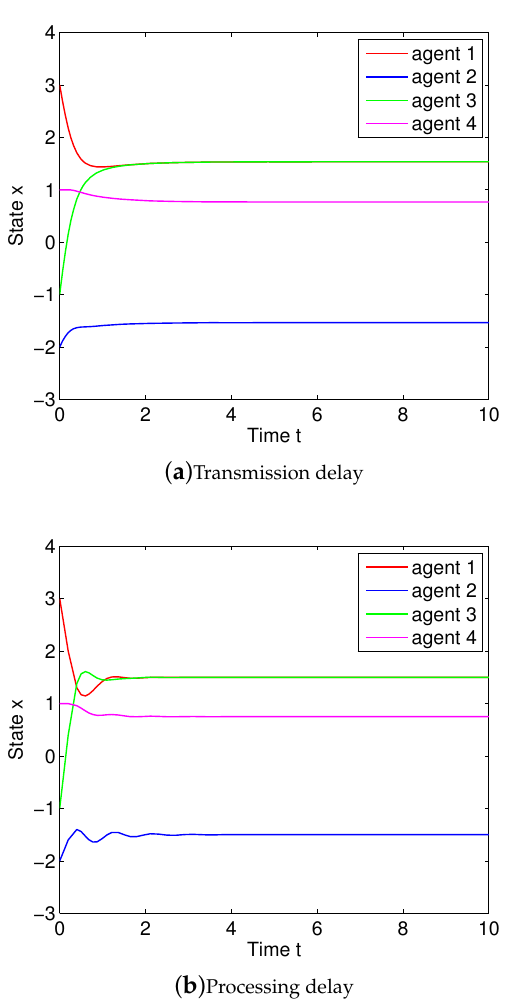
Figure 2. State evolution of agents under ( a ) signal transmission delays for system (1) with (6) and ( b ) signal processing delays for system (1) with